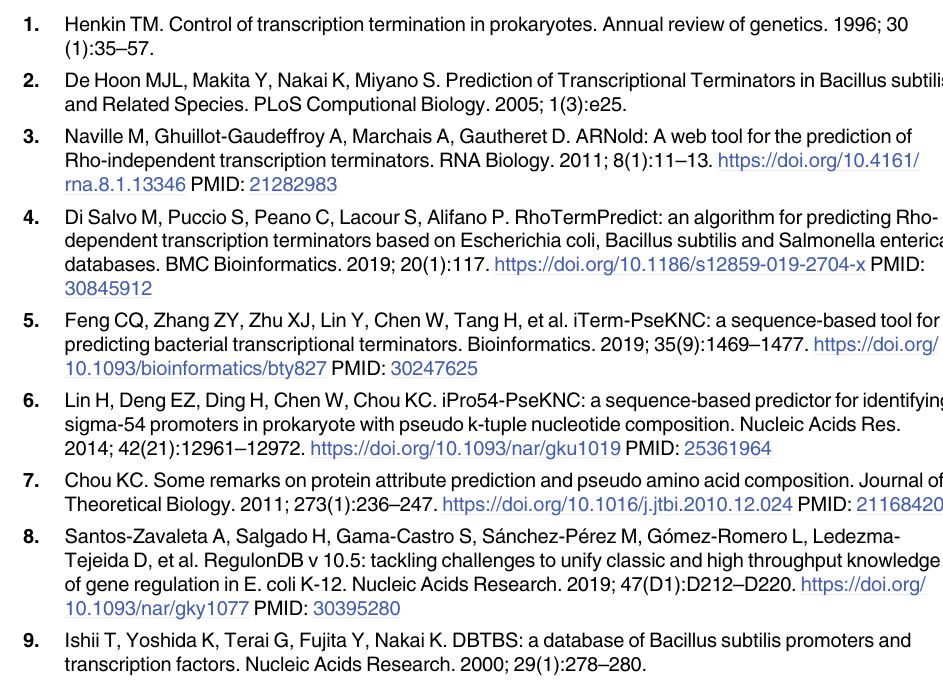
S10 Table. Trinucleotide physicochemical properties. This table contains 12 trinucleotide physicochemical properties we used and the corresponding standard